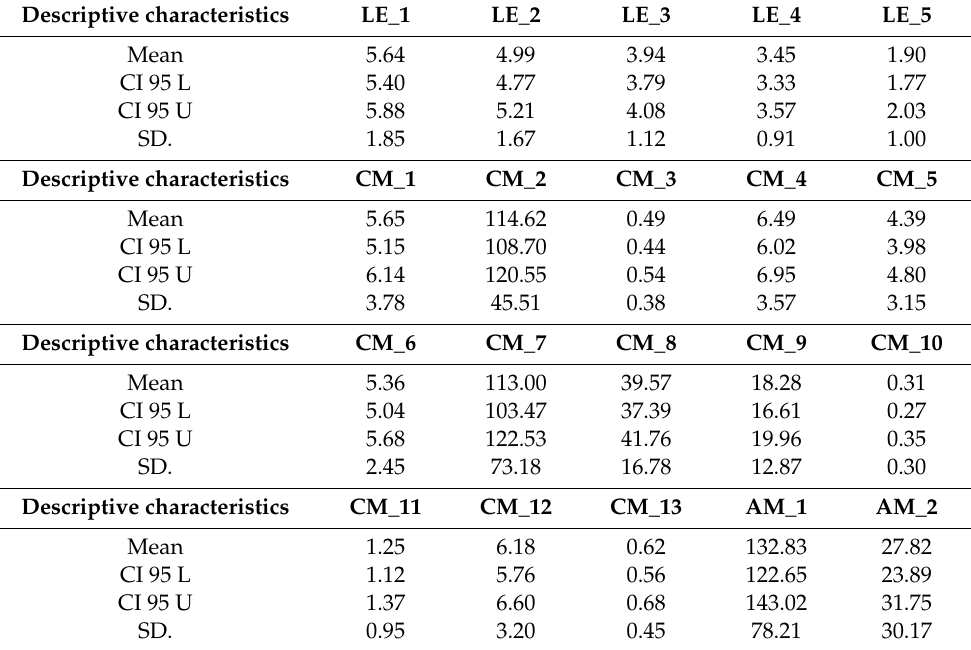
Table 2. Descriptive statistics of gender inequalities in health